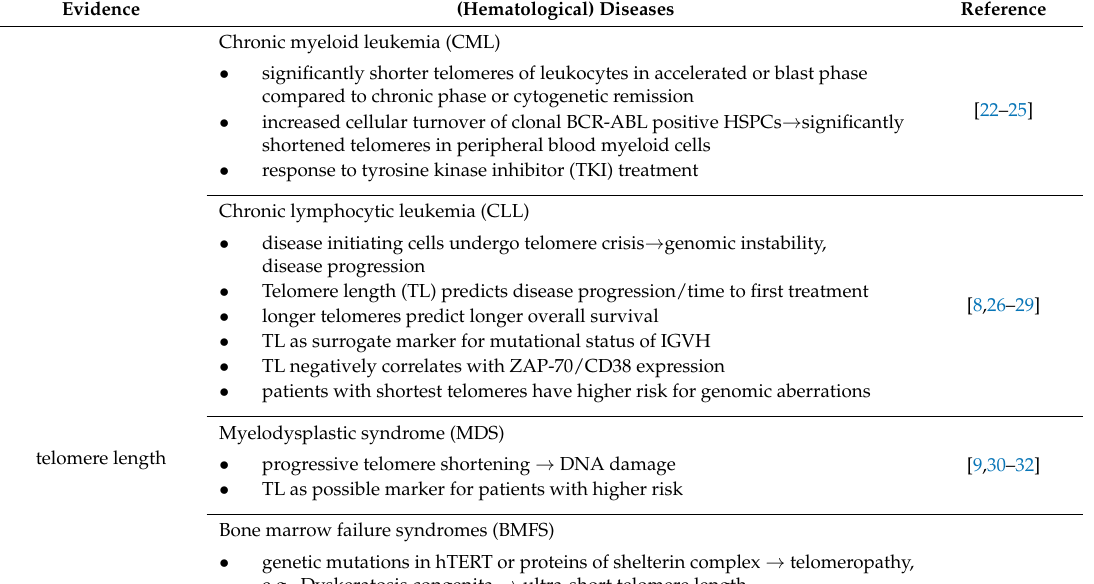
Table 1. Summary of evidence between telomere length and hematological